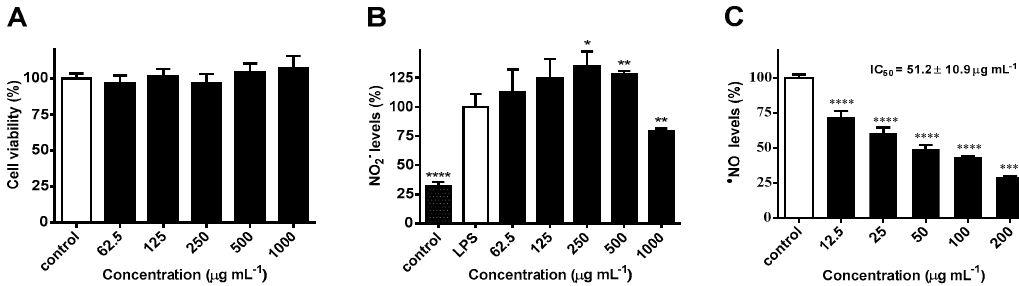
Figure 3. E ff ects of H. bhamoense trunk bark extract on RAW 264.7 cell viability ( A ), NO 2 − levels in lipopolysaccharide (LPS)-challenged RAW 264.7 cells ( B ), and • NO levels in a cell-free assay ( C ). Results correspond to the mean ± SEM of three independent experiments performed in triplicate (statistical significance: * p < 0.05, ** p < 0.01 and **** p < 0.0001).